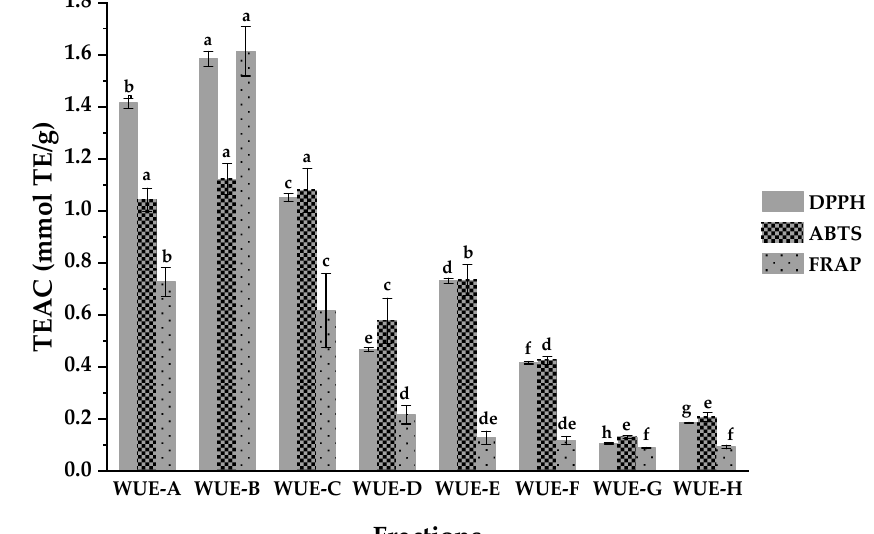
Figure 2. Trolox equivalent antioxidant capacity (TEAC) of different fractions from WUE tested by DPPH, ABTS, and FRAP assays. Means labeled by different letters ( a–h ) were significantly different at a level of p < 0.05 (n = 3) by DMRT (Duncan’s multiple range